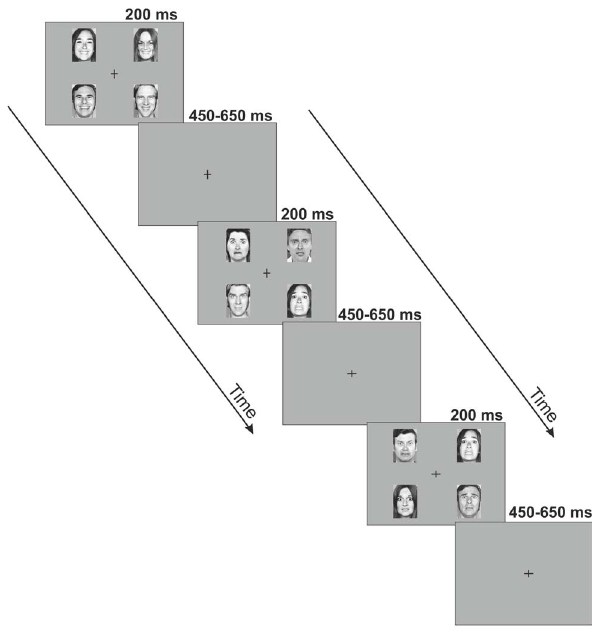
Figure 1. Stimuli and paradigm. Schematic illustration of the pattern of emotional stimuli used in the experiment. Four individual photographs displaying the same facial affect were presented on each screen for 200 ms. This screen was followed by an inter-stimulus interval randomly varying between 450–650 ms during which occa- sionally the vertical and horizontal lines of the fixation cross changed. The subjects’ task was a speeded button-press to the changes of the